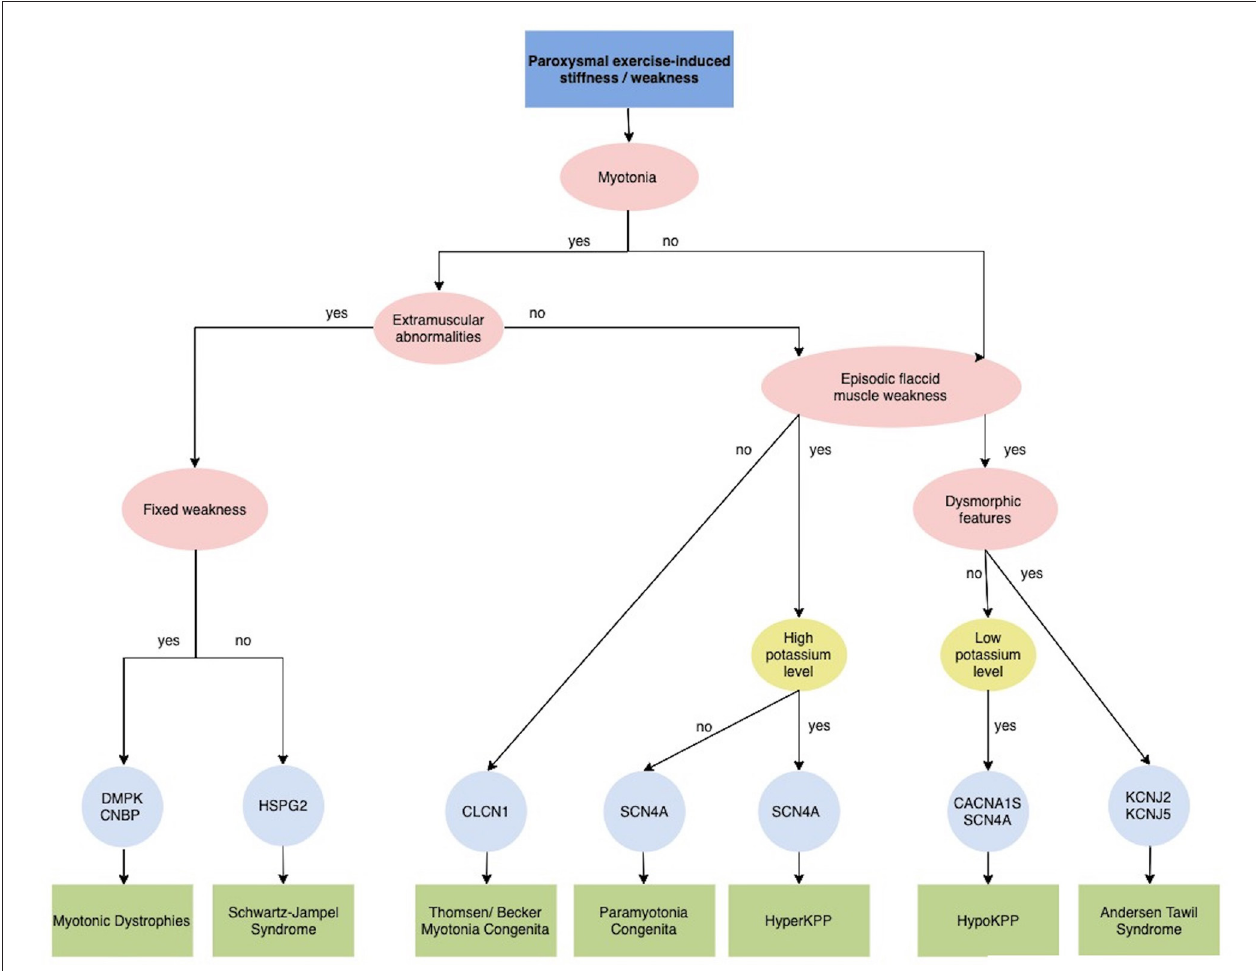
FIGURE 4 | Diagnostic algorithm for Paroxysmal exercise-induced stiffness/weakness. CACNA1S, calcium voltage-gated channel subunit alpha1S; CLCN1, chloride channel 1; CNBP, CCHC-type zinc finger, nucleic acid binding protein; DMPK, dystrophia myotonica protein kinase; HSPG2, heparan sulfate proteoglycan of the basement membrane; HyperPP, Hyperkalemic periodic paralysis; HypoPP, Hypokalemic periodic paralysis; KCNJ2, potassium voltage-gated channel subfamily J member 2; KCNJ5, potassium voltage-gated channel subfamily J member 5; SCN4A, sodium voltage-gated channel alpha subunit